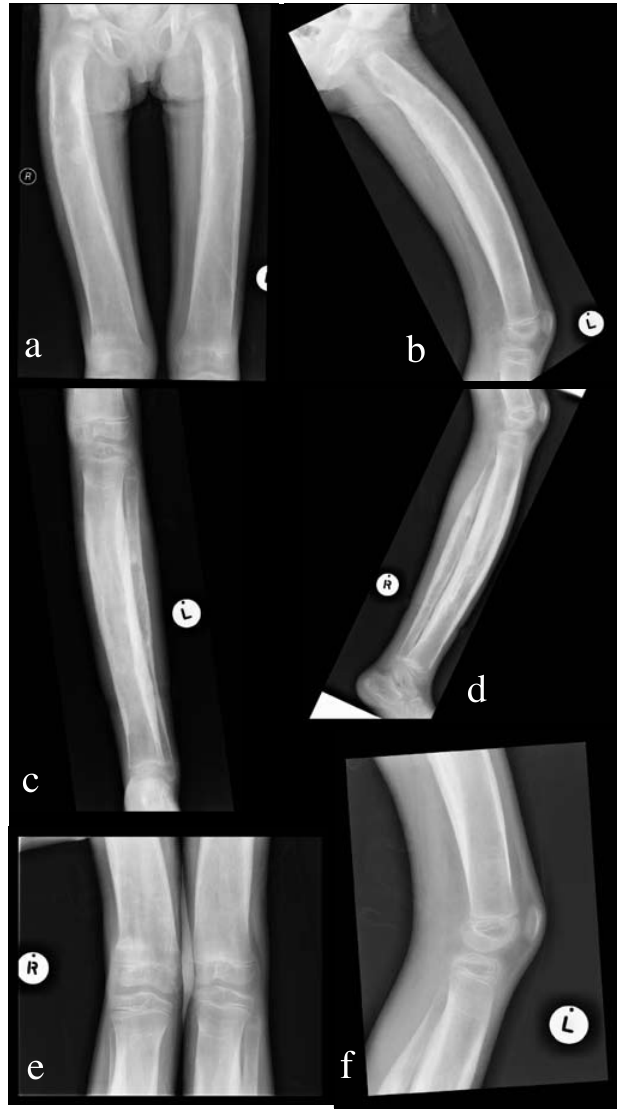
(Fig.1) affecting the long bones, calvaria, mandible and facial